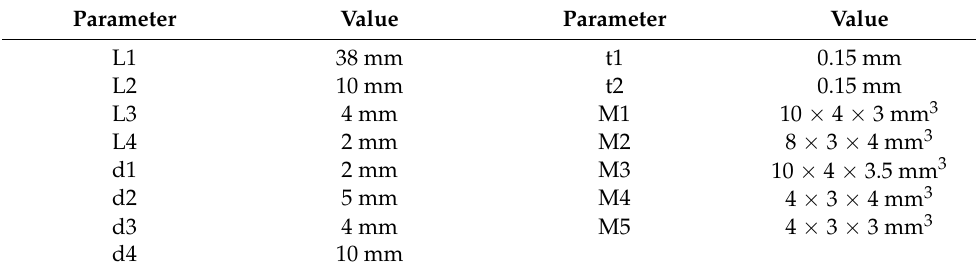
Figure 1. Schematic of the proposed PEH. ( a ) Top view; ( b ) Side view. Table 1. Geometric parameters of the proposed PEH.